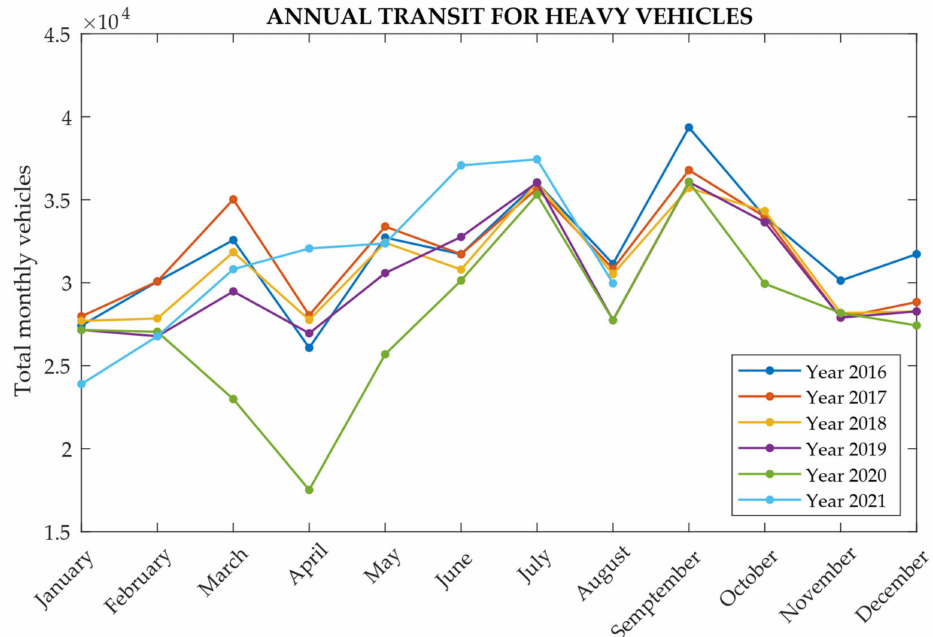
Figure 22. Data on the monthly transit of heavy vehicles between 2016 and 2021, obtained starting from 2019 in the highway section of the case study viaduct.